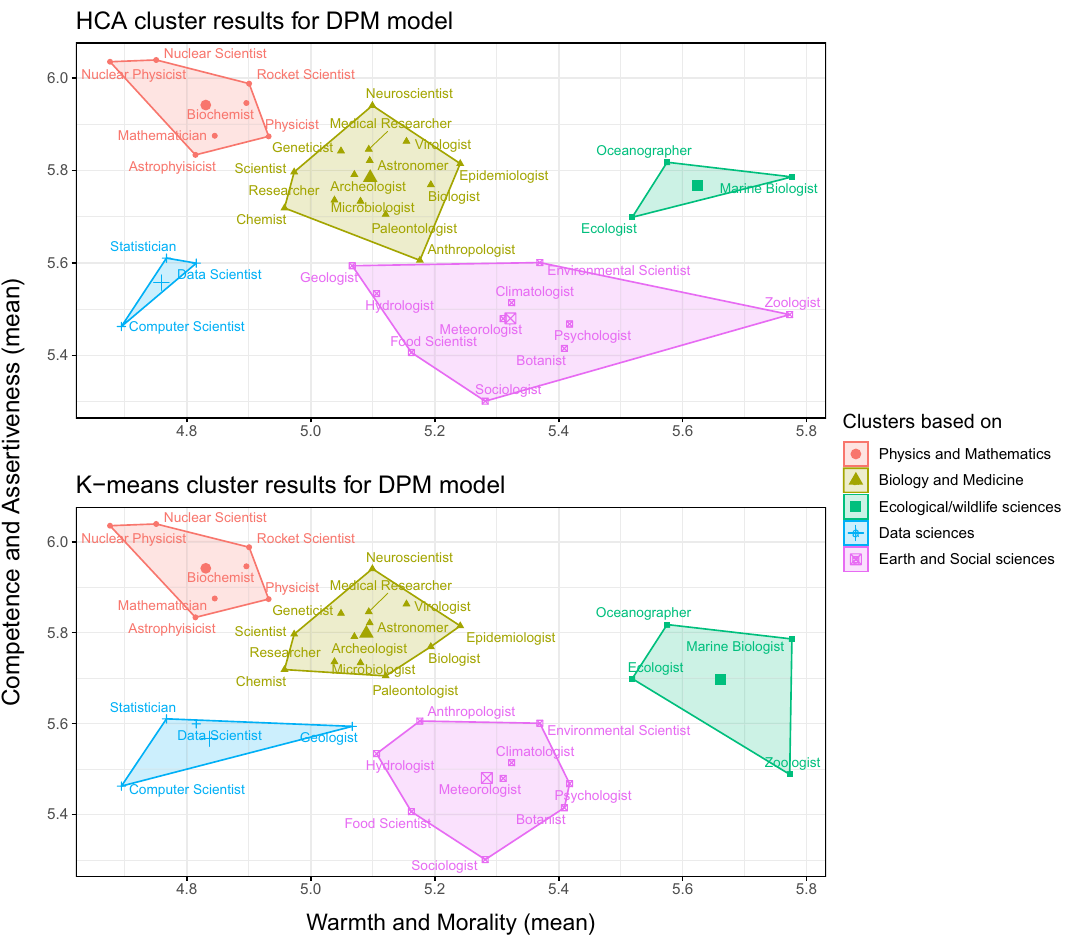
Figure 2. Five-cluster solution in Study 2b when classification is conducted using Hierarchical clustering (top) and K-means clustering (bottom). To present the clusters on a 2D graph, we calculated means of competence and assertiveness (subdimensions of agency), and warmth and morality (subdimensions of communion) 19